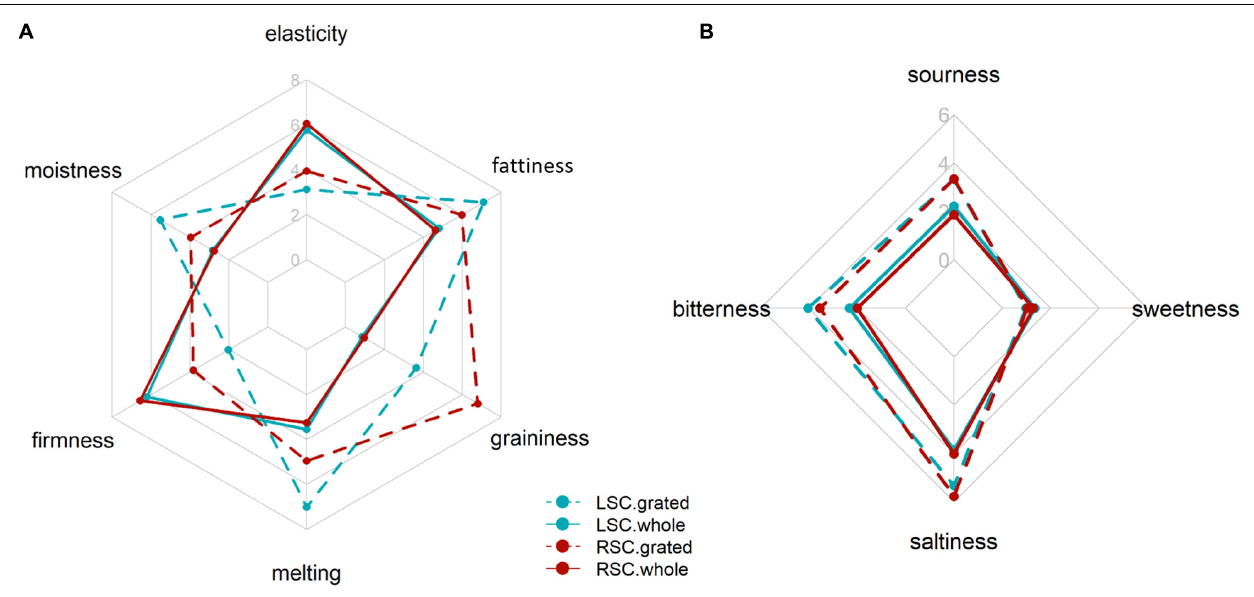
FIGURE 1 | Texture (A) and taste (B) profile of whole cheeses and grated cheeses at a regular (RSC) and low (LSC) salt content.